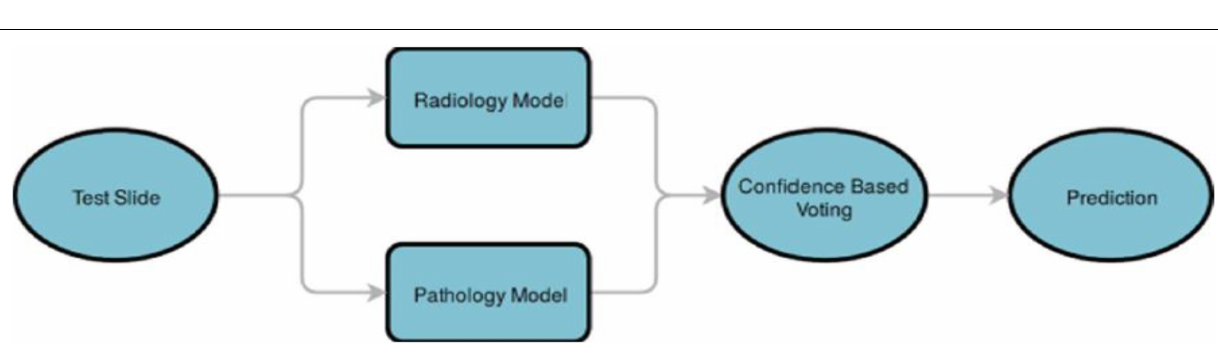
FIGURE 4 | Combining predictions from the pathology and radiology models. A test case is analyzed by the radiology classification model and the pathology classification model. The results from the two models are processed in a confidence-based voting step, which chooses the class with the highest prediction probability